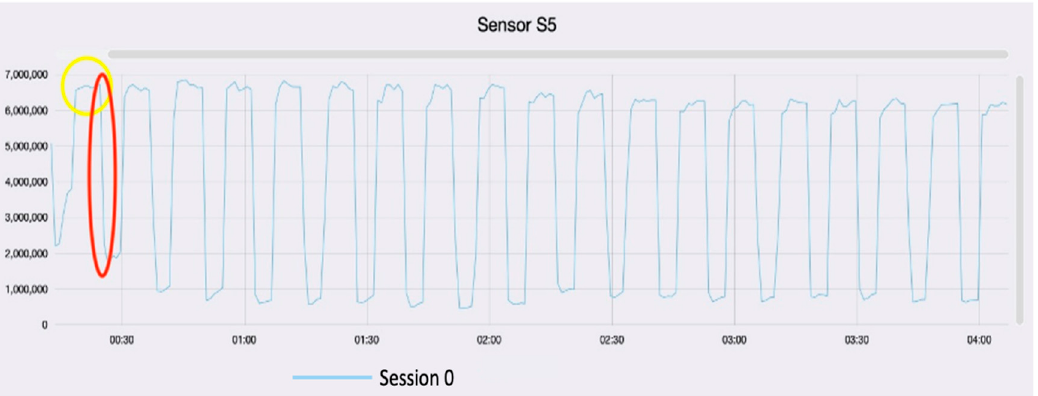
Figure 5. Graph model of sensor response to sample vinegar. x -axis presents the time of the analysis, y -axis presents the electrical resistance (Ohm). The baseline is the steady line circled in yellow. The sampling is the huge fall circled in red.